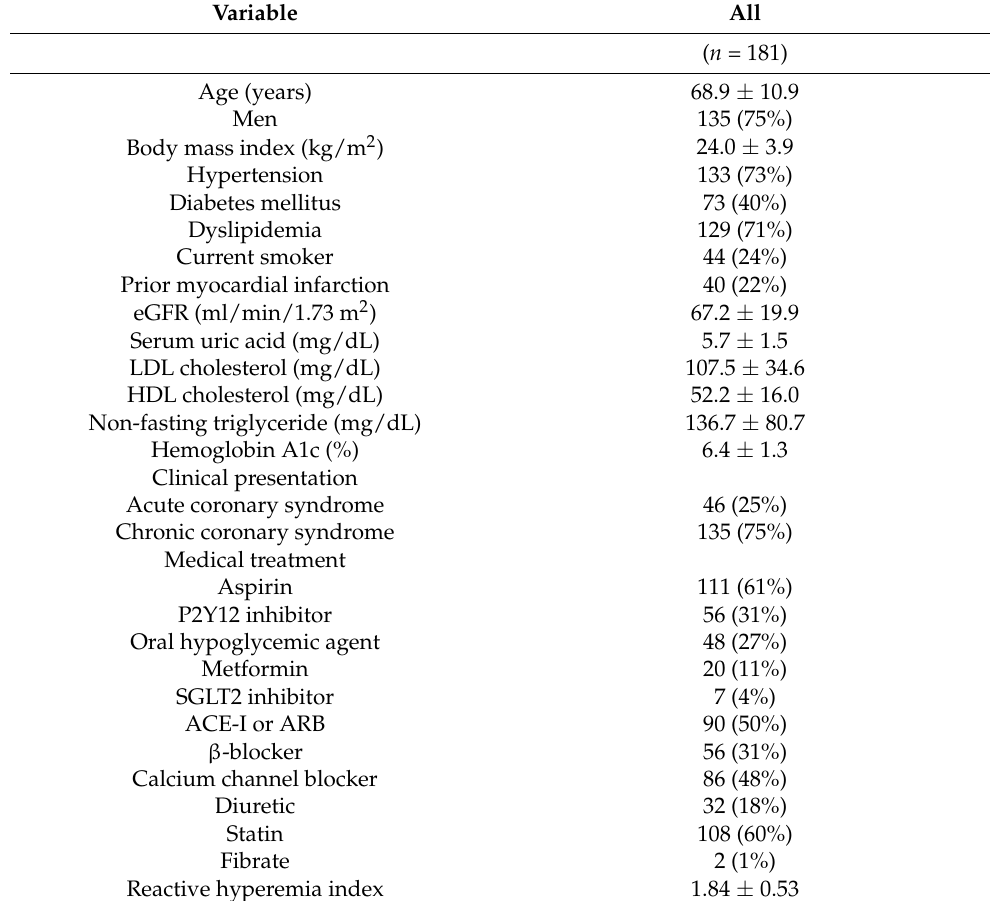
Table 1. Baseline